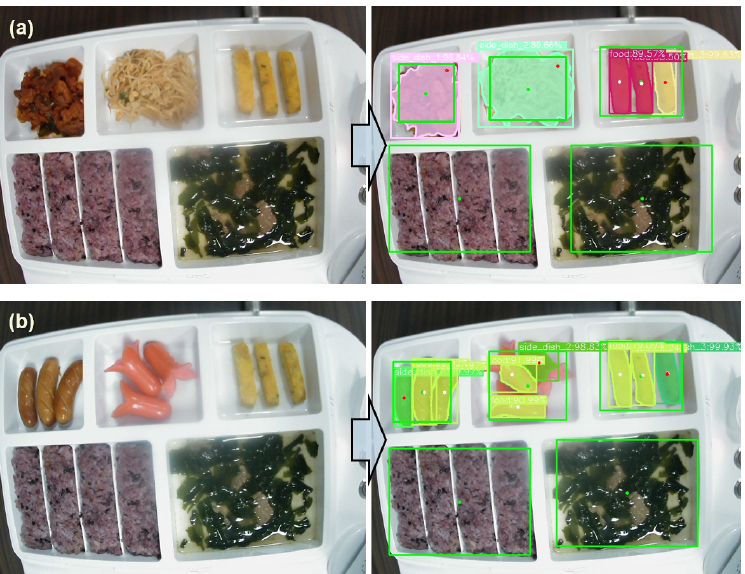
Figure 13. Food recognition results in the MAR system. ( a , b ) The pictures on the left are food images taken by the robot, which are input to the acquisition point estimator. The figures on the right are the result of the acquisition point estimator. The red dots in the right pictures indicate the points transmitted to the robot controller as acquisition points for each side